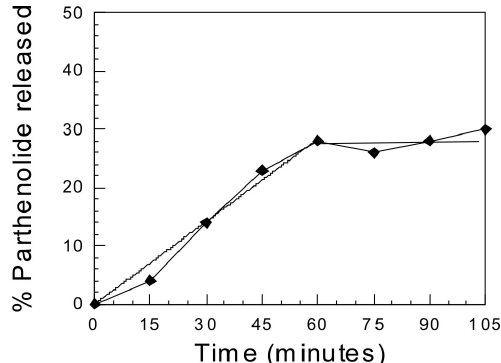
FIGURE 7 - Parthenolide dissolution from feverfew tablets in phosphate buffer pH 7.5, parthenolide released (%) x Time (min); each symbol represents the average of TABLE VI - Pharmaceutics properties of feverfew tablets Assay